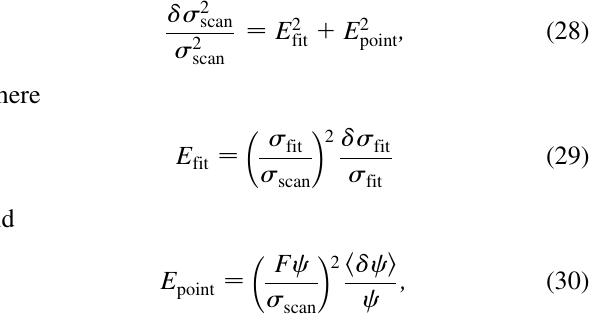
TABLE V. Optimal f -numbers (for E and the corresponding statistical precision for (cid:2) of (cid:2) ey